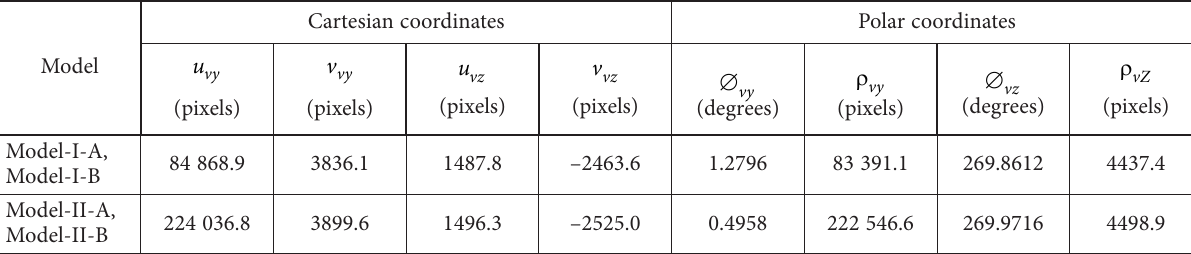
Table 4. Image cartesian and polar coordinates of vanishing points for Camera-II